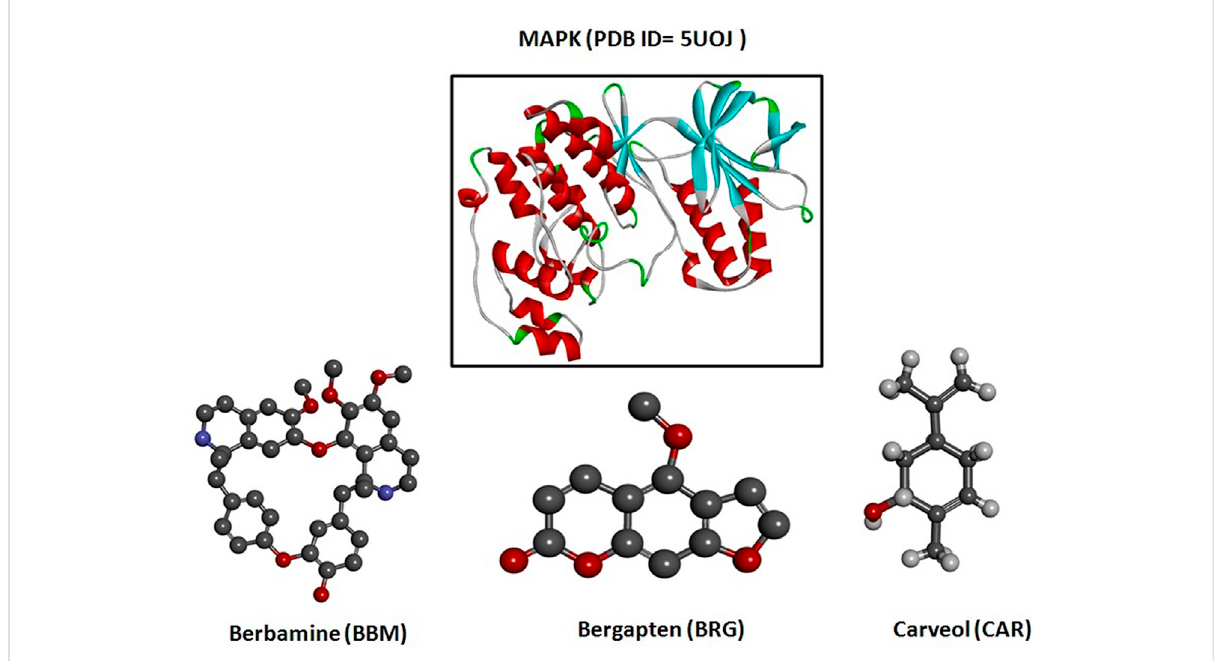
FIGURE 1 3D structures of berbamine, bergapten, and carveol and mitogen-activated protein kinase (MAPK, PDB I.D: 5UOJ) drawn through Chem Draw and Discovery Studio Visualizer client